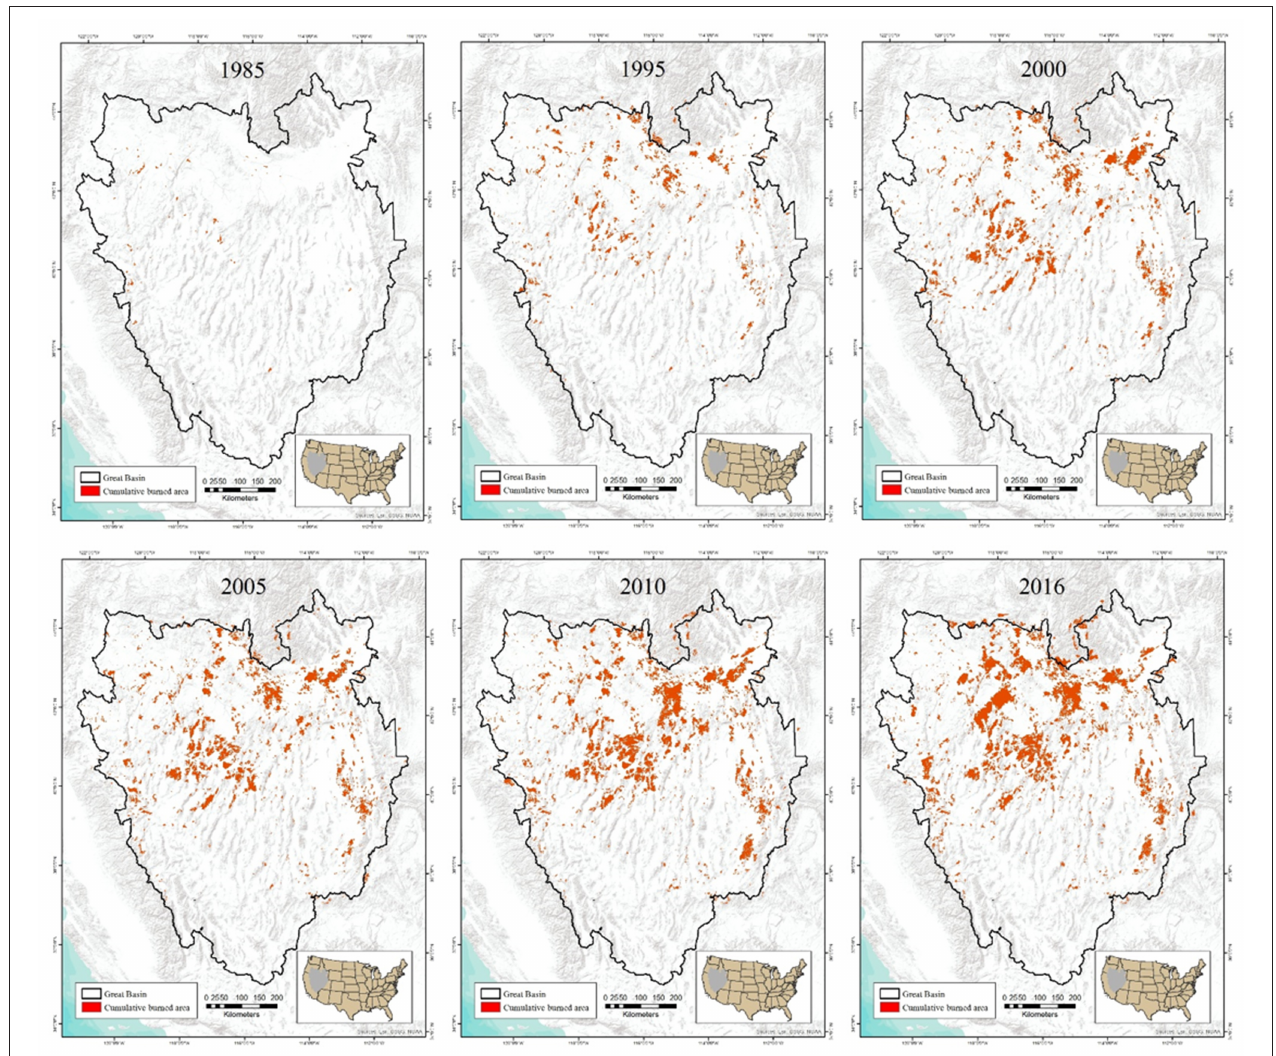
FIGURE 2 | Time series depiction of cumulative burn area (CBA) at 5–6-year intervals from 1985 to 2016 modeled with RandR-based recovery rules from Coates et al. (2016a)